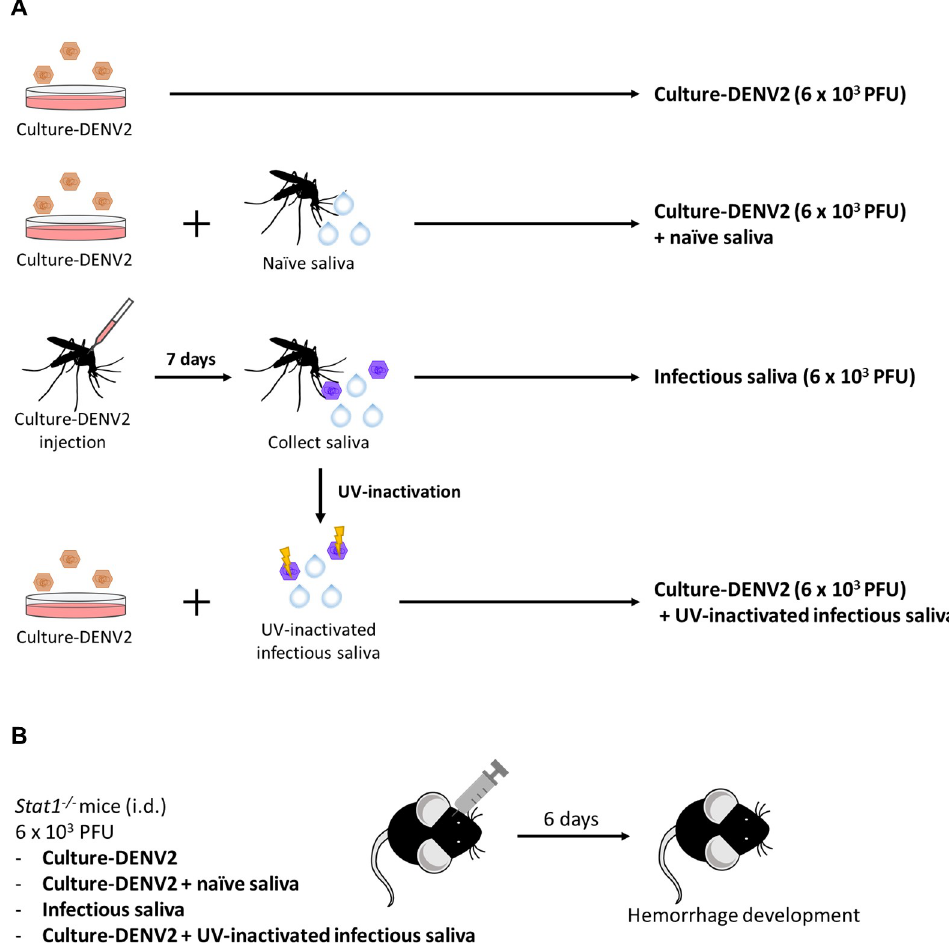
Fig 1. Scheme depicting study design. The experiment included four groups. (A, B) Inocula prepared in (A) were given to 4 groups of mice as in (B). (A) DENV2-16681 was propagated in C6/36 insect cell line and culture supernatants were collected and virus titer was determined by plague assay (culture-DENV2). Culture-DENV2 was mixed with saliva collected from na ï ve Aedes aegypti (culture-DENV + na ï ve saliva). A . aegypti was intrathoracically inoculated with 69 nl of DENV-2 16681 (6.9 × 10 2 PFU in 69 nl) and saliva was collected on day 7 after infection (infectious saliva). Culture-DENV2 was mixed with infectious saliva that was exposed to ultraviolet (UV) light (culture- DENV2 + UV-inactivated infectious saliva). The titer of DENV2 from either cell culture or infectious mosquitoes was determined by plaque assay and adjusted to 6 × 10 3 PFU in 400 μ l. (B) Four groups of Stat1 -/- mice were injected intradermally at 4 different sites on the upper back with inoculum prepared in (A) in a total volume of 400 μ l. Hemorrhage development was observed on day 6 after inoculation. been determined for their high susceptibility to low dose of DENV (S1 Fig) were divided into four groups: mice that were intradermally injected with (I) DENV2 grown in cell culture (cul- ture-DENV2), (II) culture-DENV2 pre-mixed with saliva from na ï ve mosquitoes, (III) saliva from DENV2-infected mosquitoes (infectious saliva containing DENV2), and (IV) culture- DENV2 premixed with UV-treated infectious saliva. Each mouse was injected with 6 × 10 3 PFU of DENV2 regardless whether the virus was obtained from cell culture or from infected mosquitoes (Fig 1B). Fig 2A shows that hemorrhage developed in dorsal and abdominal skins but not subcutaneous tissues in all four groups of mice on day 6 after infection. Mice that were inoculated with culture-DENV2 alone, culture-DENV2 pre-mixed with na ï ve mosquito saliva and culture-DENV premixed with UV-inactivated infectious saliva had similar level of severity